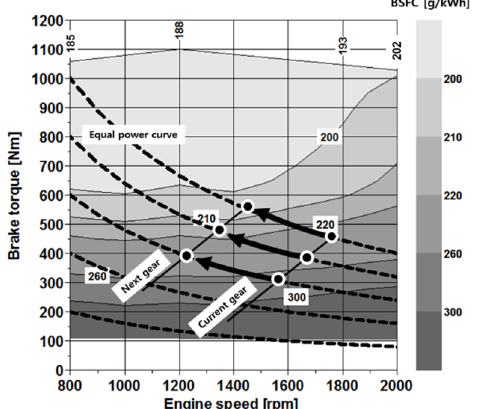
Figure 4. Schematic of brake-specific fuel consumption difference before and after gear